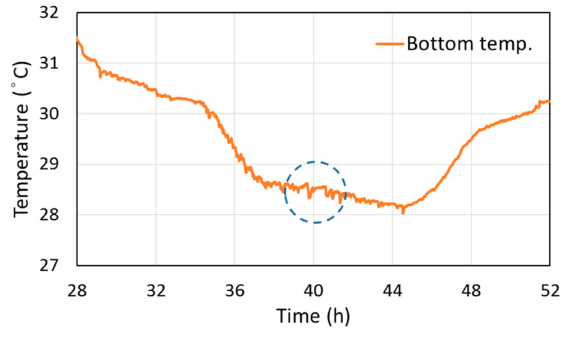
Figure 12. Minor temperature fluctuations near the 40-h time point.